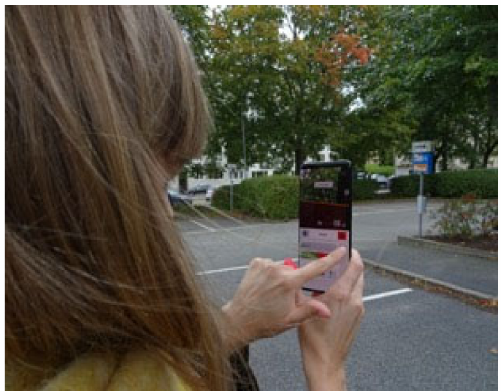
Figure 5. Stakeholder testing 1:1 on-site